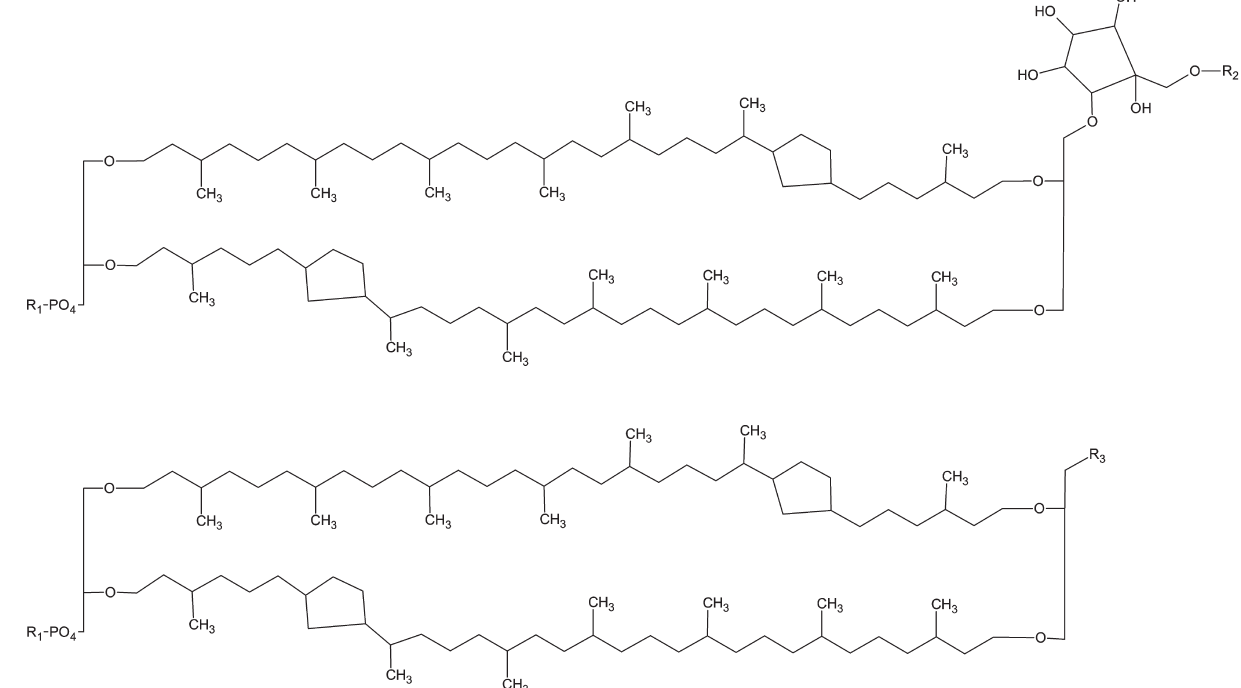
Figure 1. Structures of PLFE lipids: (top) glycerol dialkyl calditol tetraether (GDNT) and (bottom) glycerol dialkyl glycerol tetraether (GDGT). Abbreviations: R 1 = inositol; R 2 = β - D -glucopyranose; and R 3 = β - D -galactosyl- β - D -glucopyranose. The number of cyclopentane rings in each bi- phytanyl chain can vary from 0 to